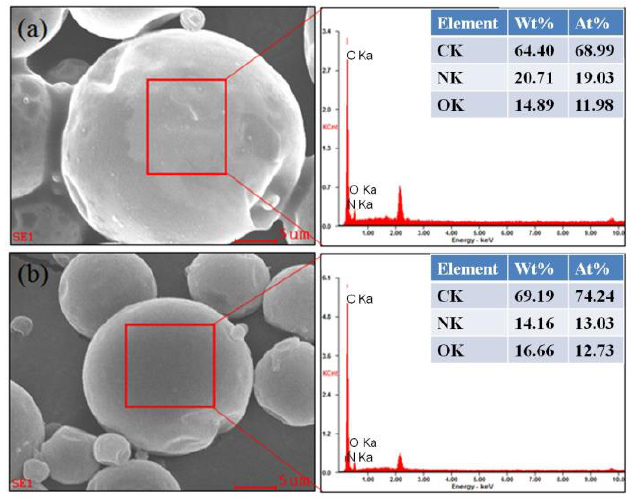
Figure 6. The EDS of MicroPCMs: ( a ) polyurea microcapsules; ( b ) polyurethane microcapsules.